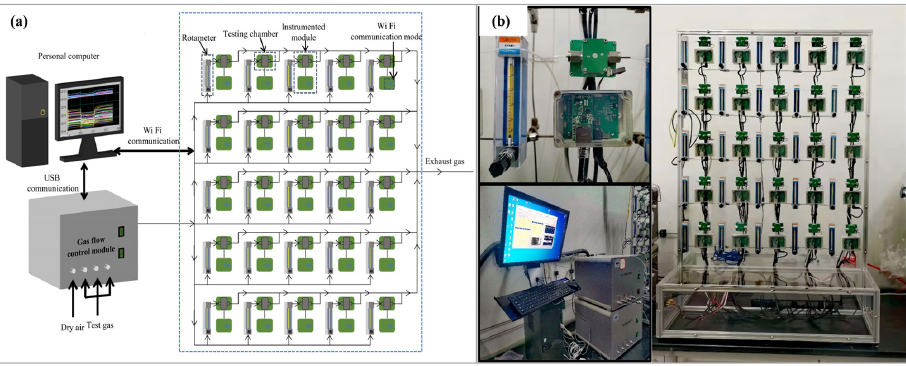
Figure 3. High-throughput screening of gas-sensitive films, ( a ) Schematic diagram, ( b ) Physical